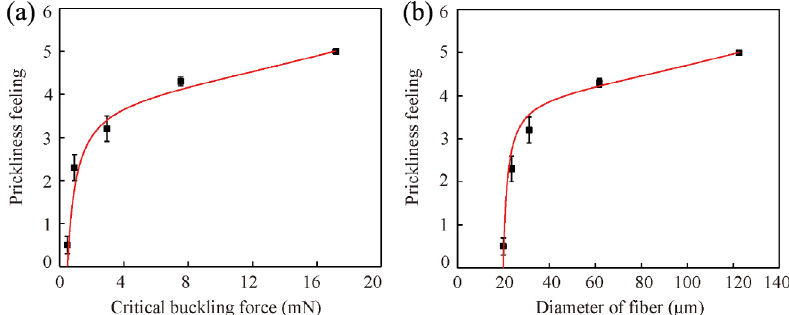
Fig. 8 Relationship between (a) critical buckling force and sensation of prickliness and that between (b) diameter of fiber and sensation of prickliness when fingers touch different